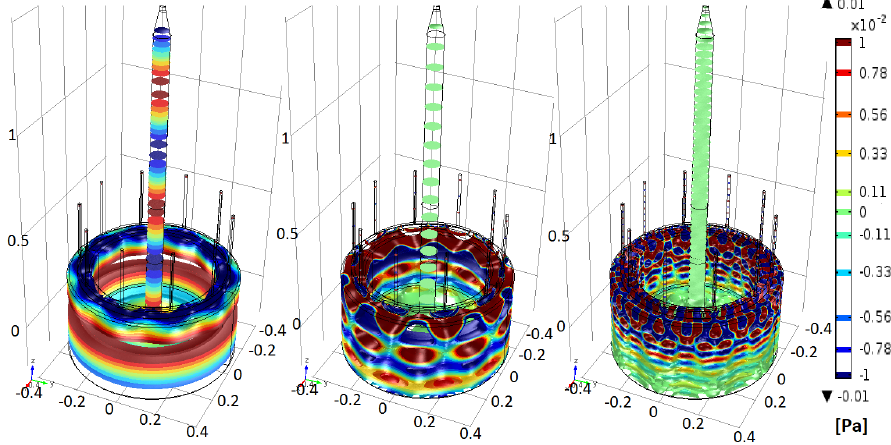
Figure 5. Acoustic pressure field isosurfaces in the primary flow circuit at 570 Hz ( left ), 1840 Hz ( center ) and 5000 Hz ( right ). The scale enhances the modes visualization, which otherwise would be very faint at full scale.